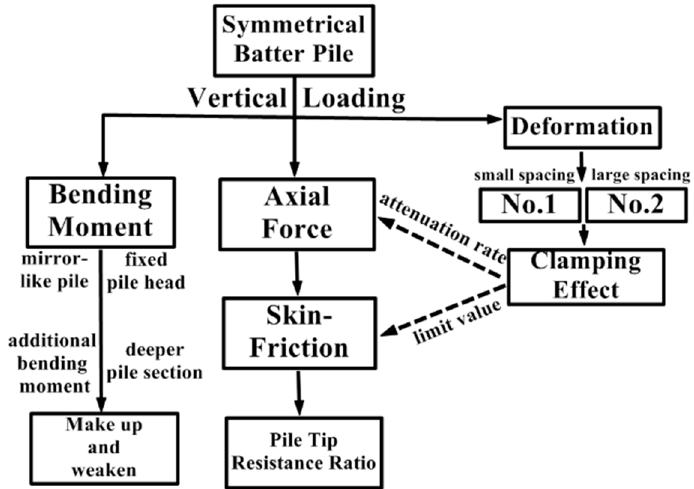
Figure 13. The load transfer mechanism of symmetrical batter piles.